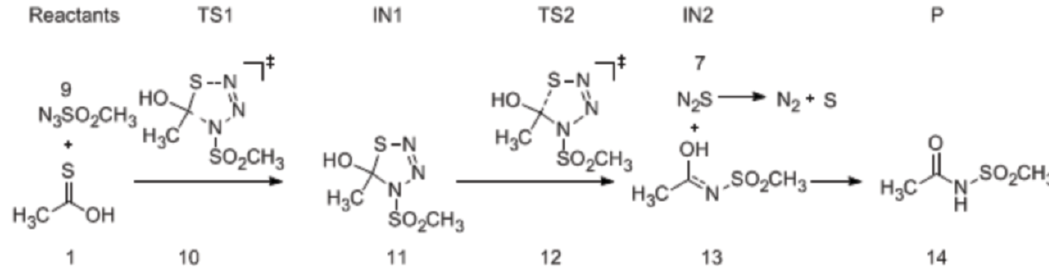
Scheme 4. Structures of reactants, transition states (TS) and intermediates (IN) of the reaction II.